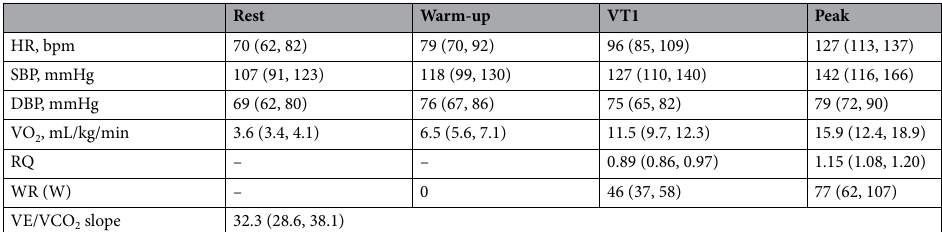
Table 2. Respiratory gas data during exercise in the patients. All values are presented as medians and IQRs. DBP diastolic blood pressure, HR heart rate, IQR interquartile range, RQ respiratory quotient, SBP systolic blood pressure, VE/VCO 2 ventilation-carbon dioxide production, VO 2 oxygen uptake, VT1 ventilatory threshold, WR work